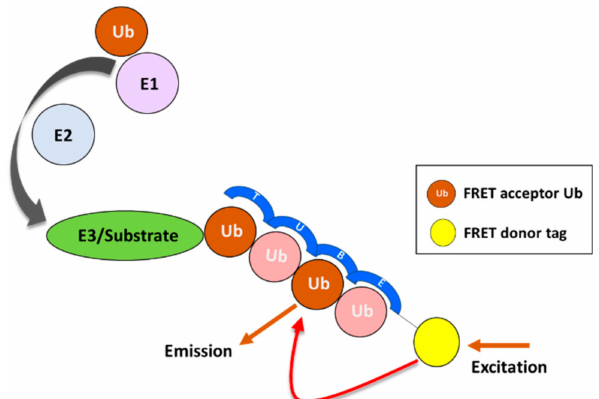
Figure 5. Detection of substrate ubiquitination using tandem ubiquitin-binding entities (TUBEs). Schematic representative of a FRET assay that involves FRET donor tag-labeled TUBEs that bind to polyubiquitin chains synthesized by the target E3 ligase.